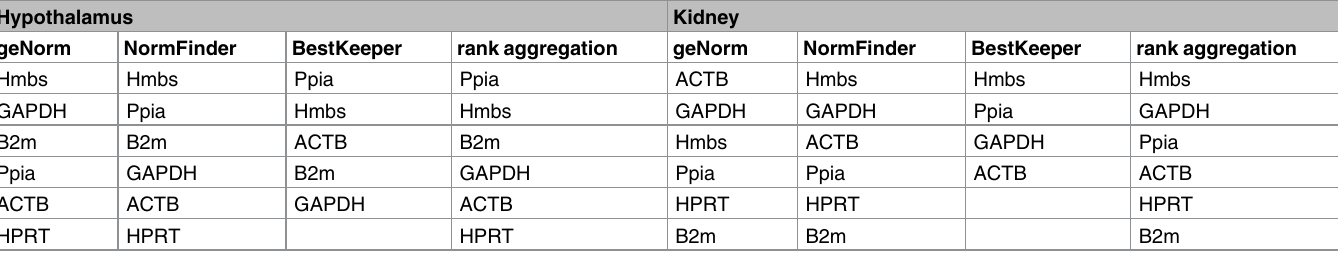
Table 4. Presents the final optimal list of genes in hypothalamus and